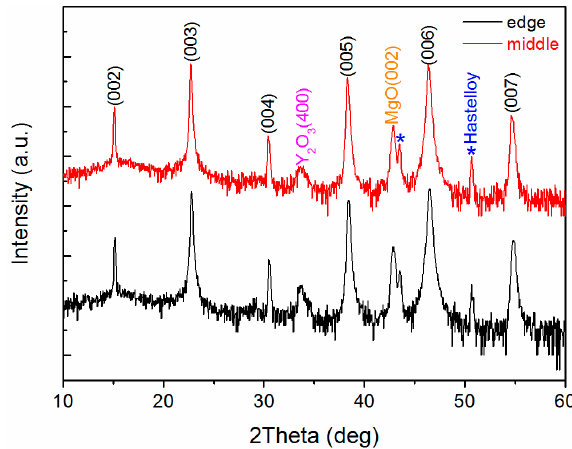
Figure 8. The XRD θ –2 θ scanning patterns of the edge and middle positions of the GdYBCO samples